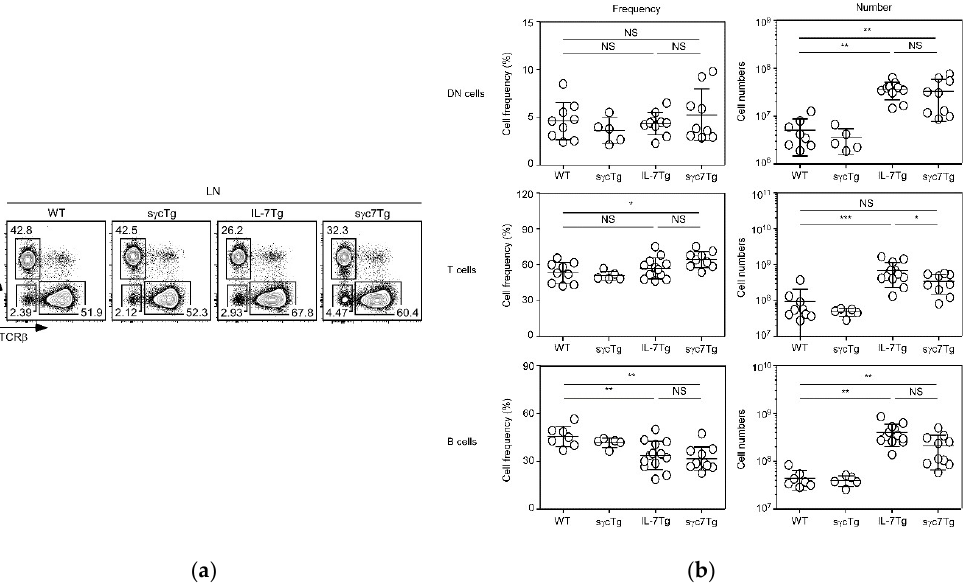
Figure 2. Frequency and total numbers of B, T, and B-T- (DN) cells in LN from the indicated mice. ( a ) Contour plots show TCRβ/B220 profiles and percentages of B, T and DN cells, respectively. ( b ) Summary of B, T, and DN cell frequency and numbers. Each symbol represents an indicated individual mouse. Horizontal lines indicate mean and SD. * p < 0.05, ** p < 0.01, *** p < 0.001, and NS mean not significant.